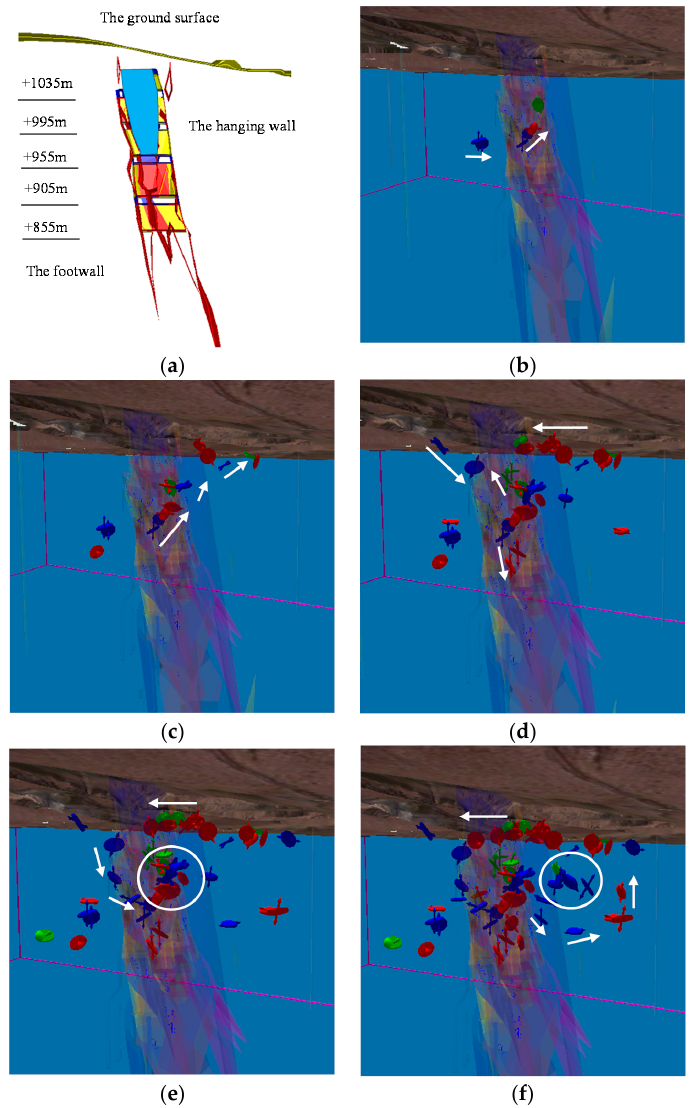
Figure 7. Ideograph of fractures extension in different time: ( a ) the section of exploration line 7; ( b ) the fractures extension in January; ( c ) the fractures extension in April; ( d ) the fractures extension in July; ( e ) the fractures extension in September; ( f ) the fractures extension in December. : the ground surface; : the marble interlayer; : room; : roof; : the ore body profile; +855 m, +905 m, +955 m, +995 m and +1035 m means the different sublevels; : tension failure; : shear failure; : mixed failure; white arrows represent the macroscopic fracture trend; white circles represent the accumulation area of fractures.